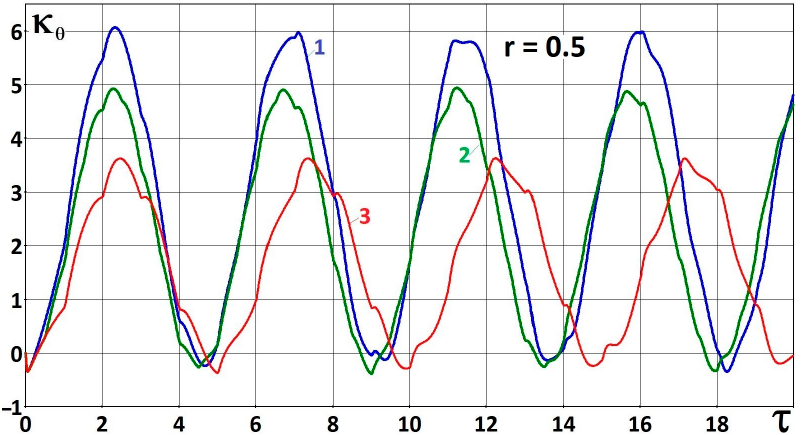
Figure 10. Time history of the relative circumferential stress at r = 0.5. Elastic materials. FGM cylinder—curve 1; two-layer cylinder—curve 2; homogeneous cylinder—curve 3.